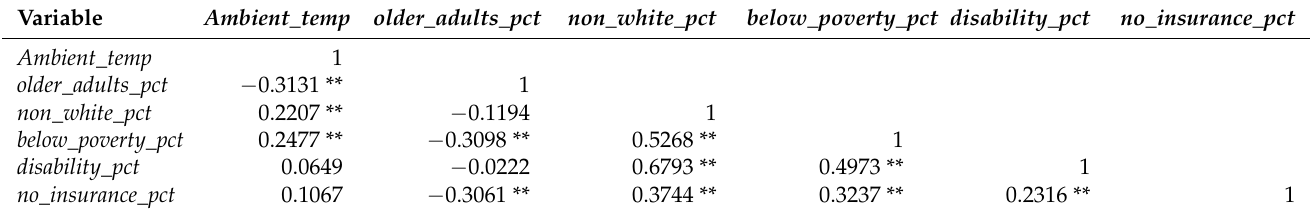
Table 2. Correlation analysis of ambient temperature and vulnerable populations ( N =